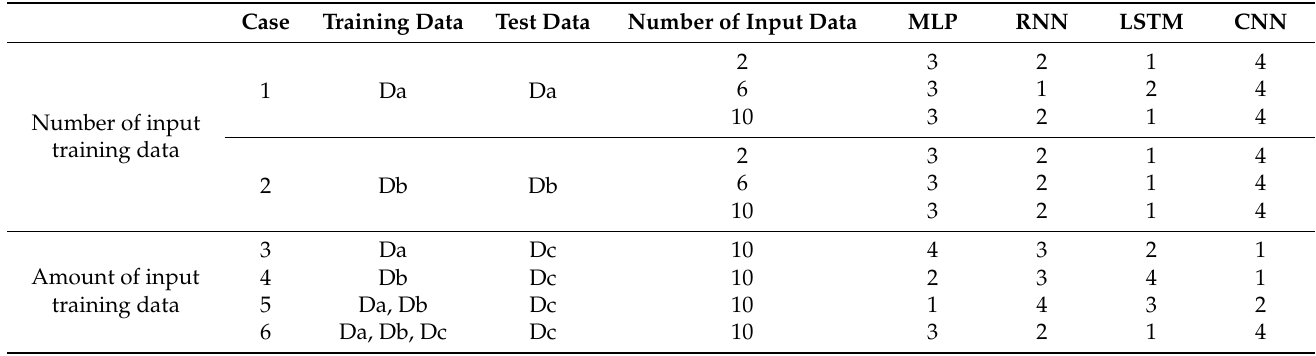
Table 2. Performance ranking for each algorithm according to changes in training data.